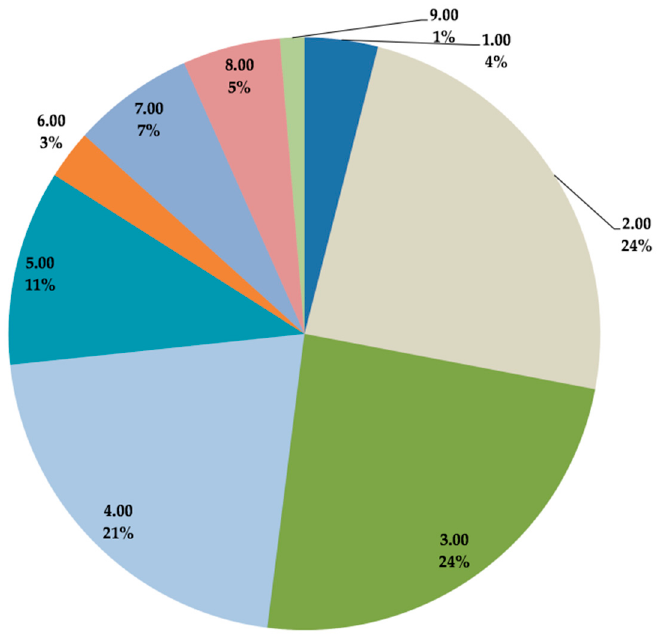
Figure 2. N umber of used Lamiaceae taxa per participant (N, %). Figure 2. Number of used Lamiaceae taxa per participant (N, %).